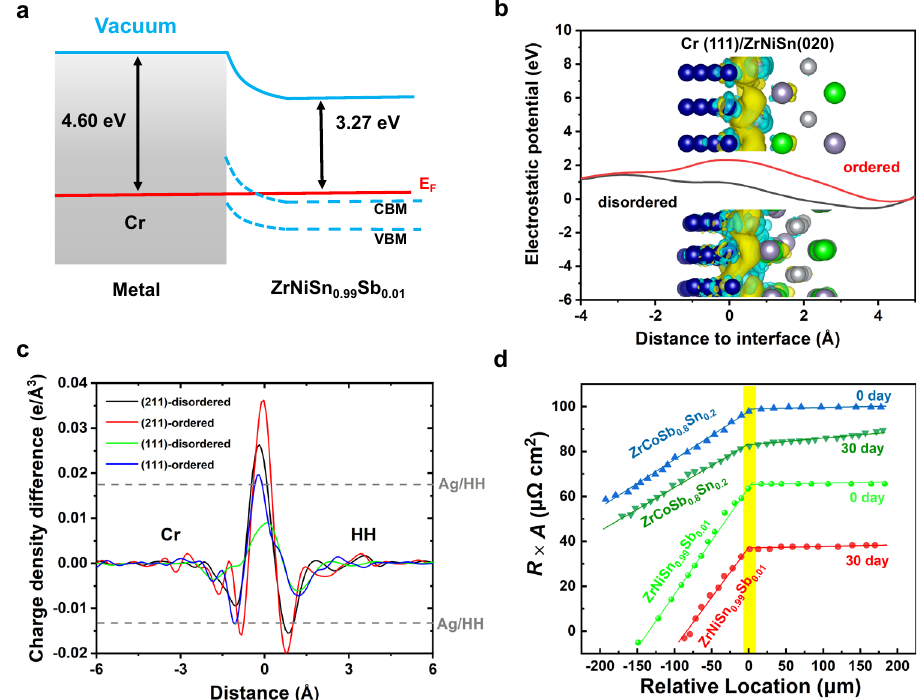
Fig.4|Electricalpropertiesofbondinginterface.a Schematicbandalignmentat the interface between Cr and n-type ZrNiSn 0.99 Sb 0.01 , the calculated work func- tions of Cr and HH are adopted from previous refs. 29, 30. b Macroscopic elec- trostatic potential at the ordered/disordered interfaces between Cr and HH, wherethechargedensitydifferencearoundtheinterfaceisalsoshown,plotusing a 0.005 e·Å − 3 isosurface. Blue, gray, silver and green atoms represent Cr, Sn, Ni